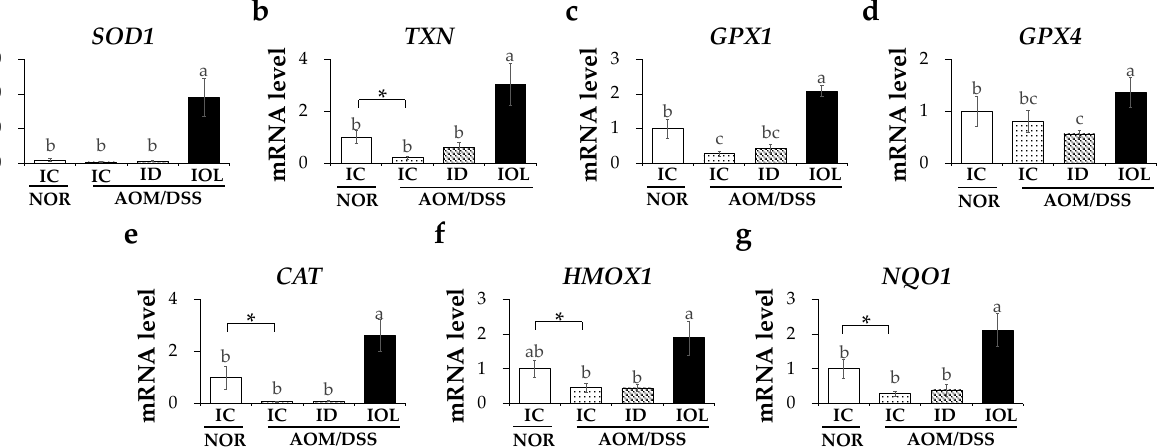
Figure 5. Iron overload diet enhanced the expression of antioxidant pathway genes. mRNA expres- sion level of SOD1 ( a ), TXN ( b ), GPX1 ( c ), GPX4 ( d ), CAT ( e ), HMOX1 ( f ) and NQO1 ( g ) released from the large intestine tissue were measured. Data are expressed as Mean ± SD and SE. One-way ANOVA was used for the test of difference and Tukey for the post-hoc test. Different letters above the value indicate statistical significance. Student’s t -test was used to test the difference between two groups and the asterisk represents statistical significance (* p < 0.05). Abbreviations: NOR, nor- mal; AOM/DSS, azoxymethane/dextran sodium sulfate; IC, iron control; ID, iron-deficient; IOL, iron overload; SOD1 , superoxide dismutase 1; TXN , thioredoxin; GPX1 , glutathione peroxidase 1; GPX4 , glutathione peroxidase 4; CAT , catalase; HMOX1 , heme oxygenase 1; NQO1 , NAD(P)H quinone dehydrogenase 1.